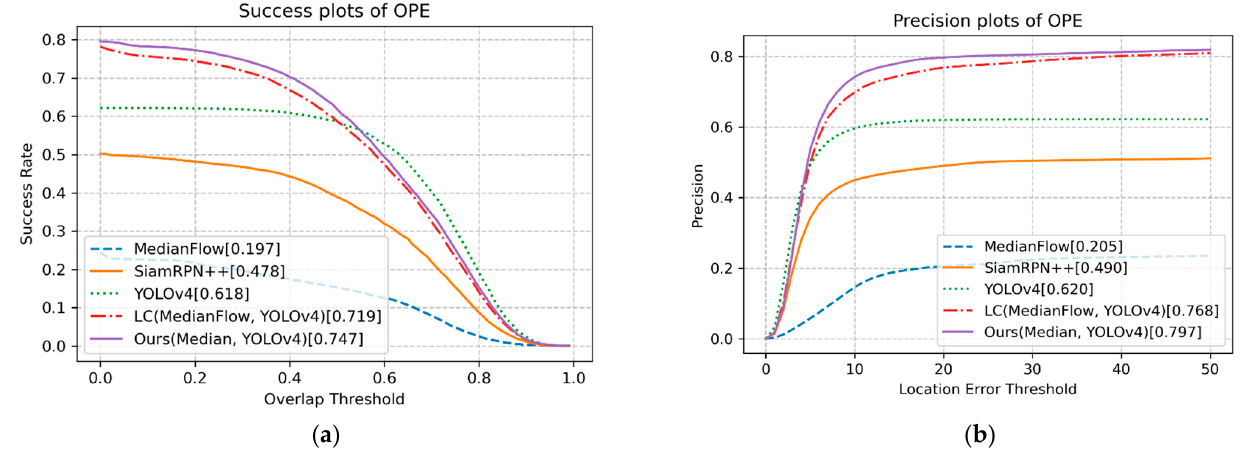
Figure 4. ( a ) Success plots of test sequences; ( b ) precision plots of test sequences.